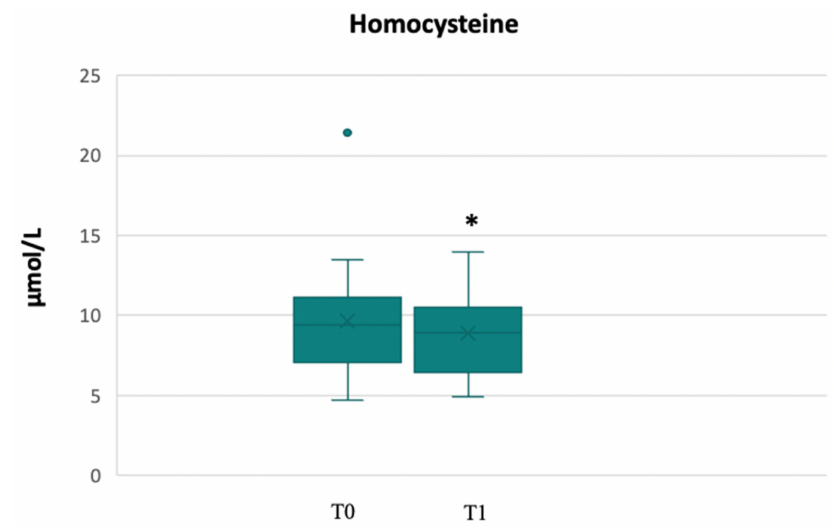
Figure 3. Changes in homocysteine levels from T0 to T1. * p < 0.05. Regarding inflammatory status, hs-CRP levels were beyond the normal range in 14.3% of the patients. At T1, we found a slight reduction, even if not statistically significant, in this parameter (1 mg/L vs. 0.8 mg/L). At T2, in the sample that completed the study, we observed a median value of hs-CRP of 0.6